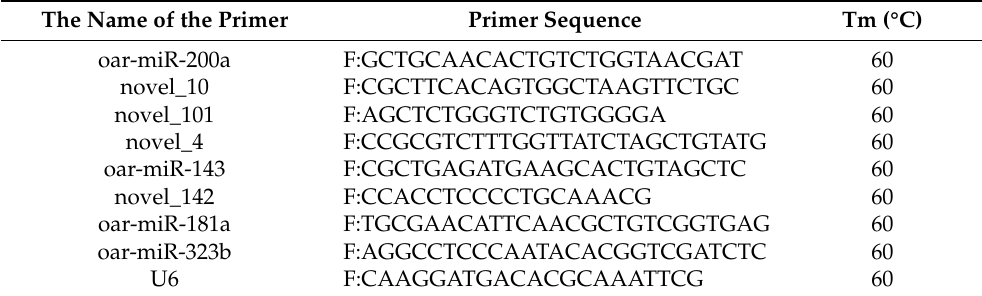
Table 2. The Details of Primers of